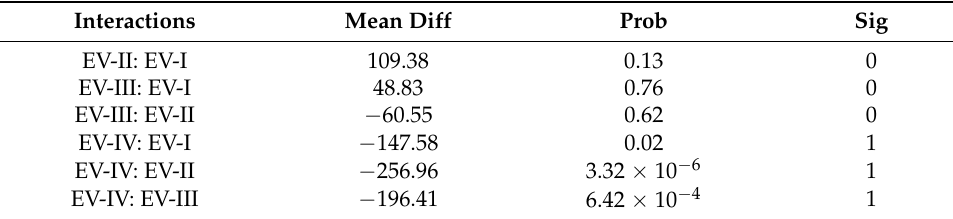
Table 5. One-way ANOVA tenacity comparison along the fiber sections.